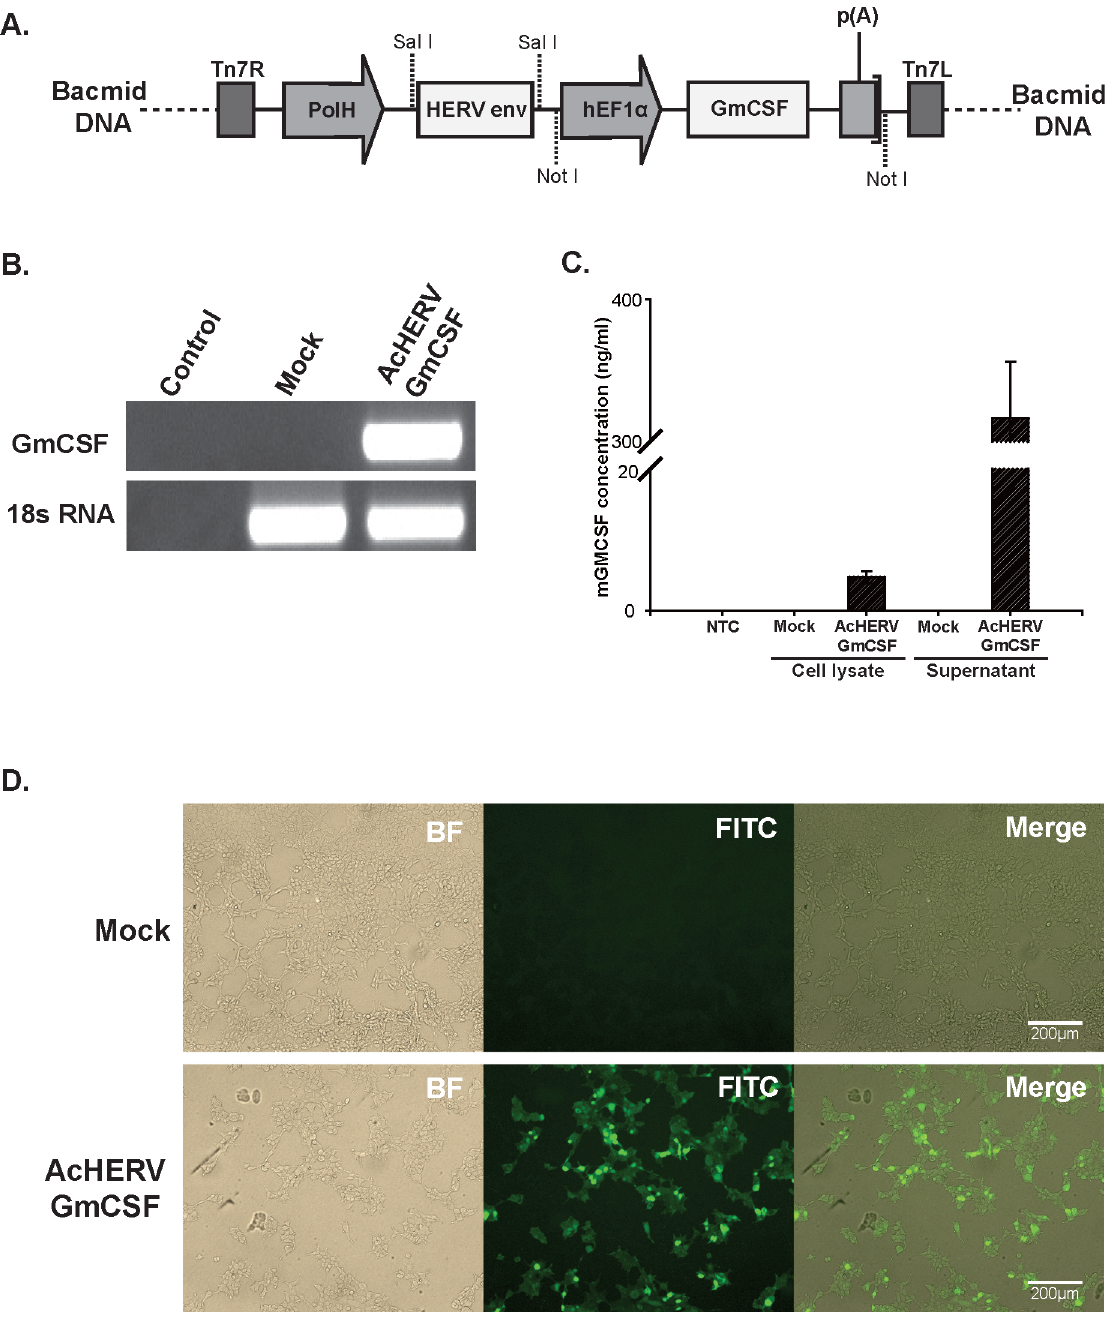
Fig 1. Diagram of the recombinant baculovirus, AcHERV-GmCSF, and its expression in mammalian cells. (A) Diagram of Bacmid DNA of AcHERV-GmCSF containing HERV envelope and GmCSF genes under the transcriptional control of the AcMNPV PolH and hEF1 α promoters, respectively. (B) Detection of mRNAs for GmCSF and 18s rRNA in baculovirus-infected 293TT cells by RT-PCR. Lane 1: Control for RT-PCR; lane 2: mock infection with AcMNPV in 293TT cells; lane 3: AcHERV-GmCSF-infected 293TT cells. (C) Quantification of GmCSF expression in baculovirus-infected 293TT cell lysates and supernatants by ELISA. NTC, not treated control; Mock, AcMNPV baculovirus-infected cells; AcHERV-GmCSF, AcHERV-GmCSF-infected cells. (D) Fluorescence micrograph of baculovirus-infected 293TT cells. Seventy-two hours after infection, the cells were incubated with a monoclonal mouse antibody against GmCSF followed by incubation with a FITC-conjugated goat anti-mouse IgG antibody. Mock, AcMNPV-infected cells; AcHERV-GmCSF, AcHERV-GmCSF-infected cells; Merge, merged image.